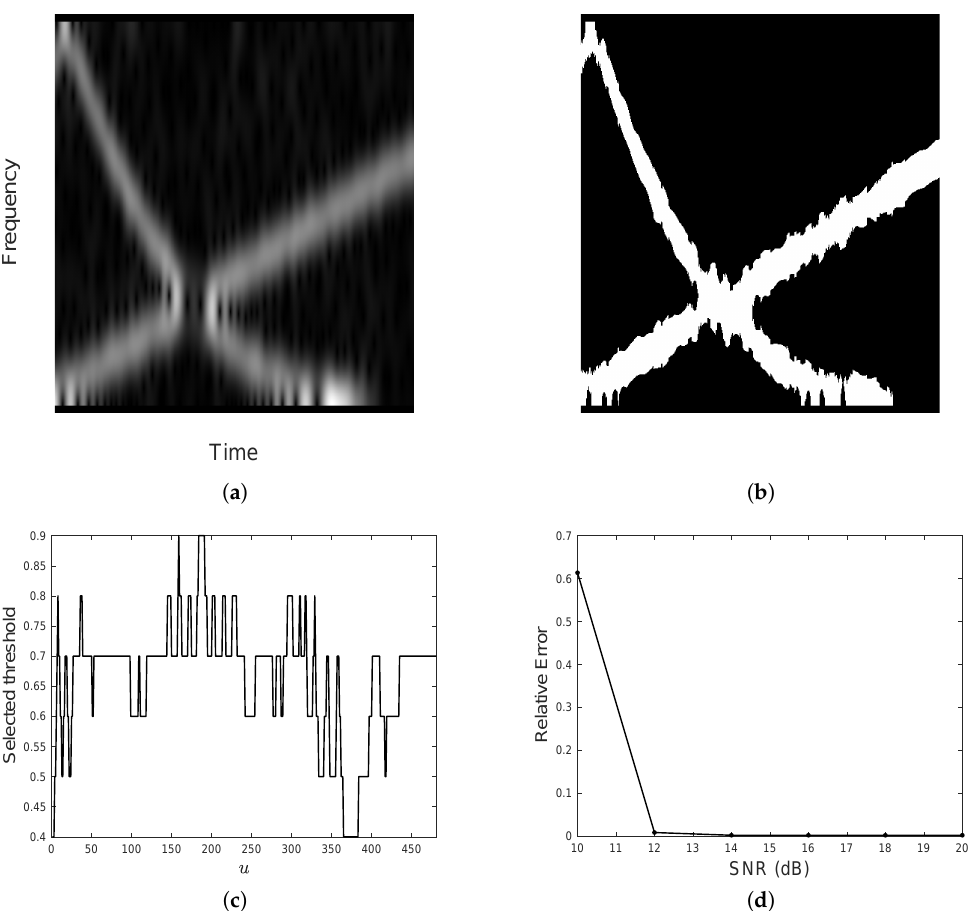
Figure 12. ( a ) Spectrogram of the two-component FM signal in Figure 11, embedded with AWG noise, SNR = 14 dB, s = 32. ( b ) Binary map derived from ( a ), with removed black holes. ( c ) Optimal threshold provided by MDL functional minimization, according to Equation (18). ( d ) Relative counting error against